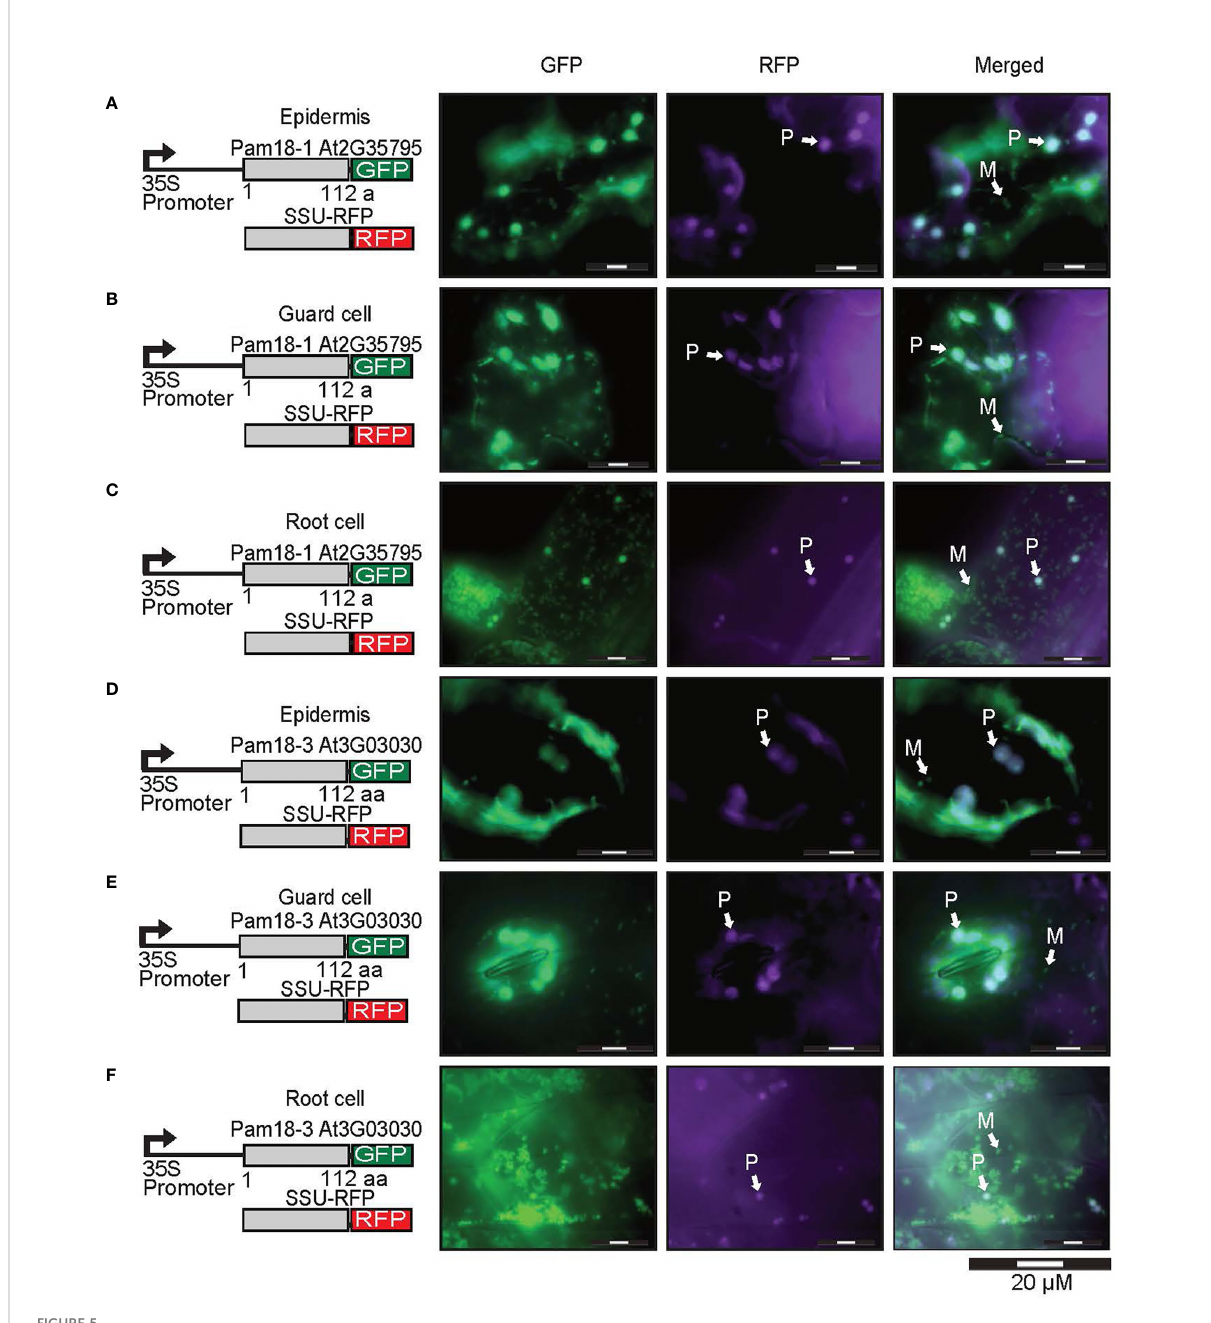
FIGURE 5 Pam18-1 and Pam18-3 GFP with SSU-RFP in stable transgenic Arabidopsis seedlings. Images taken from 3 weeks old Arabidopsis T2 transformants of root, epidermal, and guard cells Pam18-1 (A – C) . Pam18-3 (D – F) . Scale bar indicates 20 m M. M, mitochondria, P,